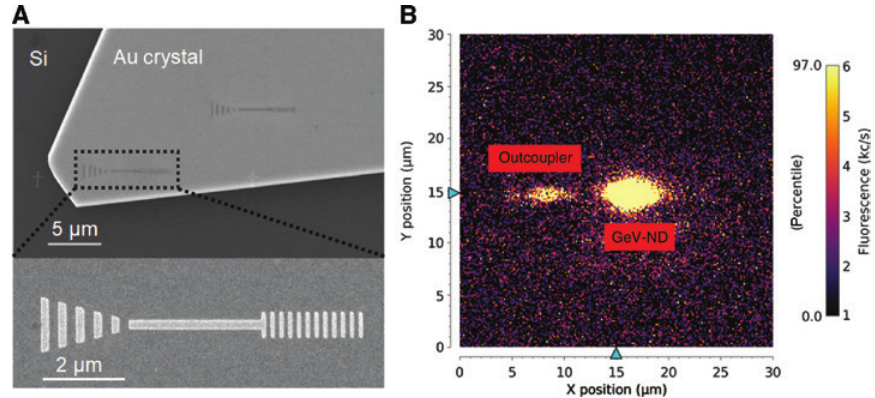
Figure 3: Unidirectional plasmonic excitation of a single GeV color center in an ND. (A) SEM image of the fabricated device on gold crystal. The periodicity of the RBG is 240 nm. (B) Galvanometric mirror scan image of the coupled